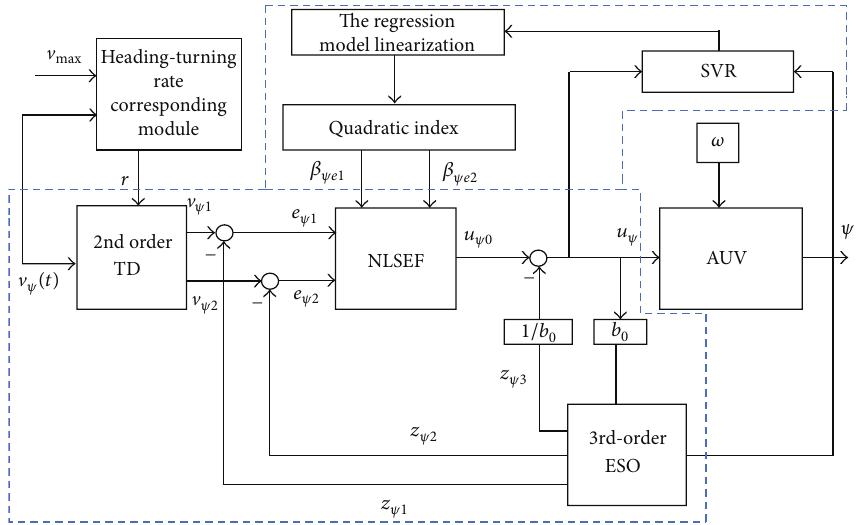
Figure 2: The algorithm of SVR-ADRC for steering control.